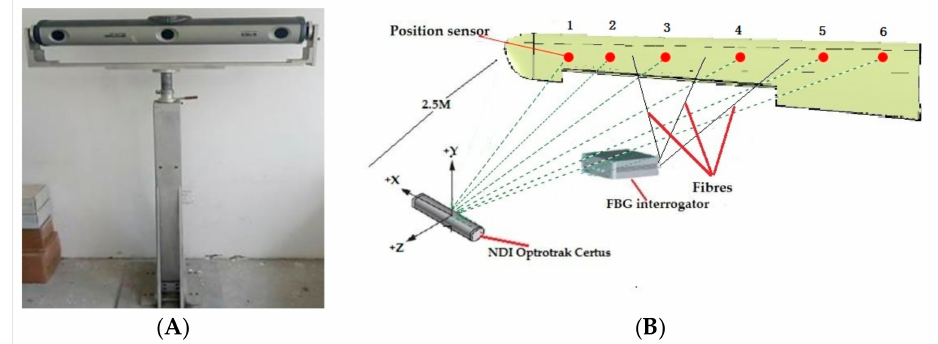
Figure 14. Wing tests. ( A ) NDI Optrotrak Certus; ( B ) experiment